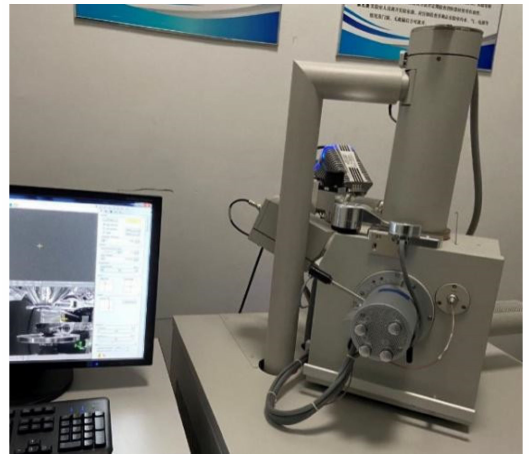
Figure 5. SEM and Energy Disperse